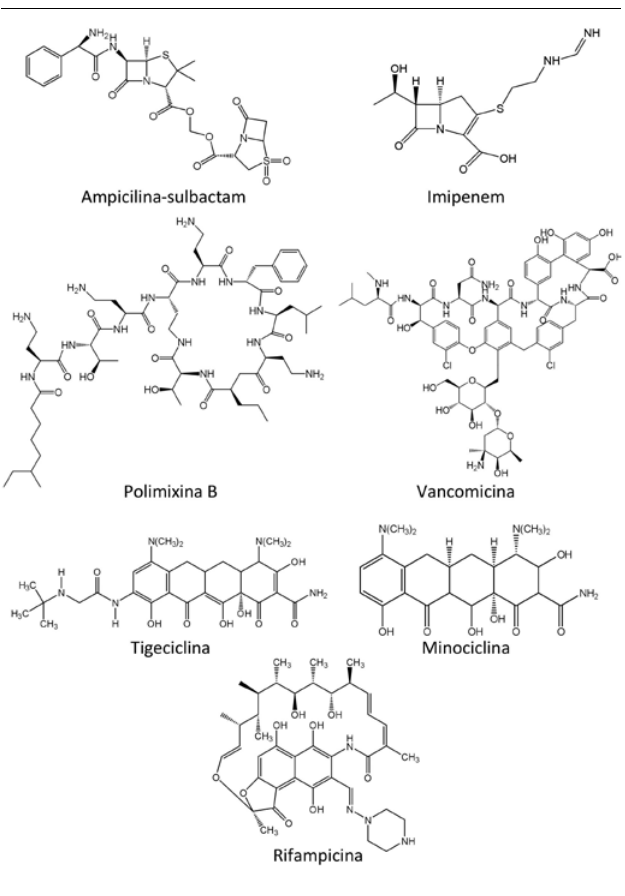
figurE 3 – Chemical structures of the major antimicrobial compounds applied in the clinical treatment of Acinetobacter